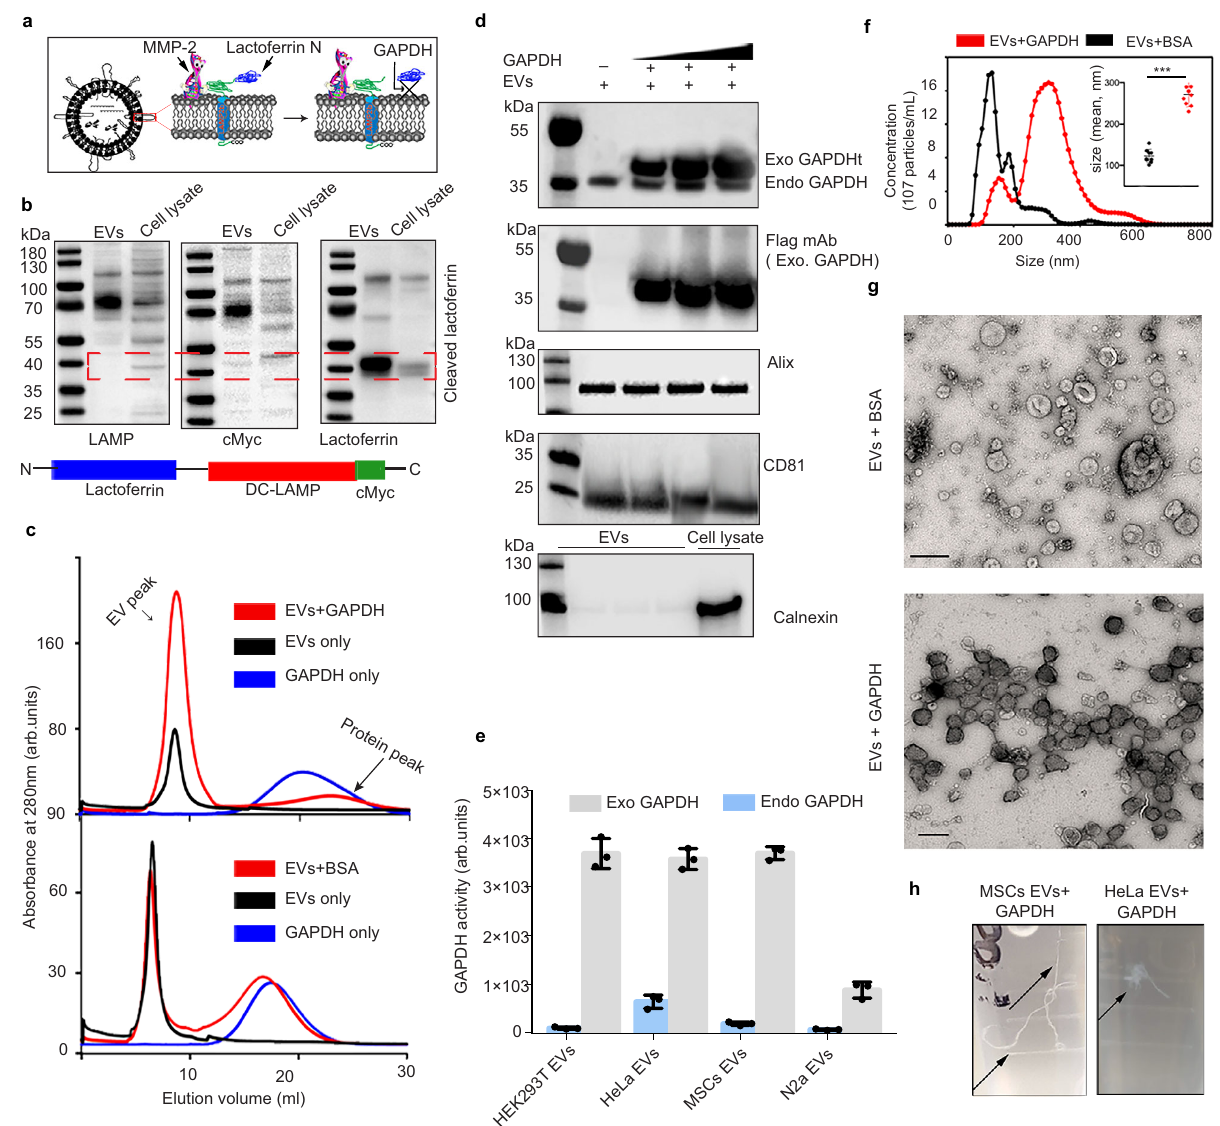
Fig. 1 Surface binding of GAPDH leads to aggregation of EVs. a Cartoon representation of lactoferrin N cleavage from DC-LAMP by MMP-2 enzyme, and attachment of the cleaved lactoferrin on the EV surface via GAPDH protein. b Western blotting of puri fi ed HEK293T EVs and cell lysate showing expression of lactoferrin N-DC-LAMP and cleavage of lactoferrin from DC-LAMP (Dendritic cell-Lysosomal associated membrane protein). Arrangement of the different domains of the protein is shown in the schematic. The experiment was independently repeated two times. c UV-absorbance spectrum for EVs, EVs + GAPDH and EVs + BSA after passing through gel- fi ltration column. GAPDH and BSA protein alone were used as negative controls to rule out aggregation of the proteins. The experiment has been independently repeated three times. d Western blot showing exogenous binding of GAPDH to HEK293T EVs. Increasing concentrations of histidine-(His6) and Flag-tagged GAPDH were incubated with a fi xed number of EVs. Endo GAPDH Endogenous GAPDH, Exo GAPDH exogenous GAPDH. Alix and CD81 are EV protein markers used as positive controls. Calnexin (bottom blot) was used to demonstrate the purity of EV samples. The experiment has been independently repeated two times. e GAPDH activity assay of EVs and EVs + Exo GAPDH. For EVs + Exo GAPDH activity, GAPDH protein was added to EVs in concentrated (10×) complete tissue culture media (Media + 10% FBS) followed by gel fi ltration to isolate EVs. Results are shown as mean ± s.d ( n = 3 independent biological experiments). f NTA pro fi le showing the size distribution of puri fi ed HEK293T EVs after incubation with either GAPDH or BSA proteins respectively. Inset is the scatter plot representing size (mean) of EVs. Data shown as mean ± s.d. ( n = 3 independent biological experiments) Statistical differences were determined by unpaired two-sided Student ’ s t-test. *** P < 0.0001. g Electron microscopy images of EVs incubated with either BSA or GAPDH protein (scale bar indicates 200 nm). h Photographic images of tubes showing the formation of thread-like structures from MSCs and HeLa EVs after incubation with GAPDH for 2 h at 4 °C. Experiment of ( g and h ) were independently repeated two times. Source data are provided as a Source Data fi